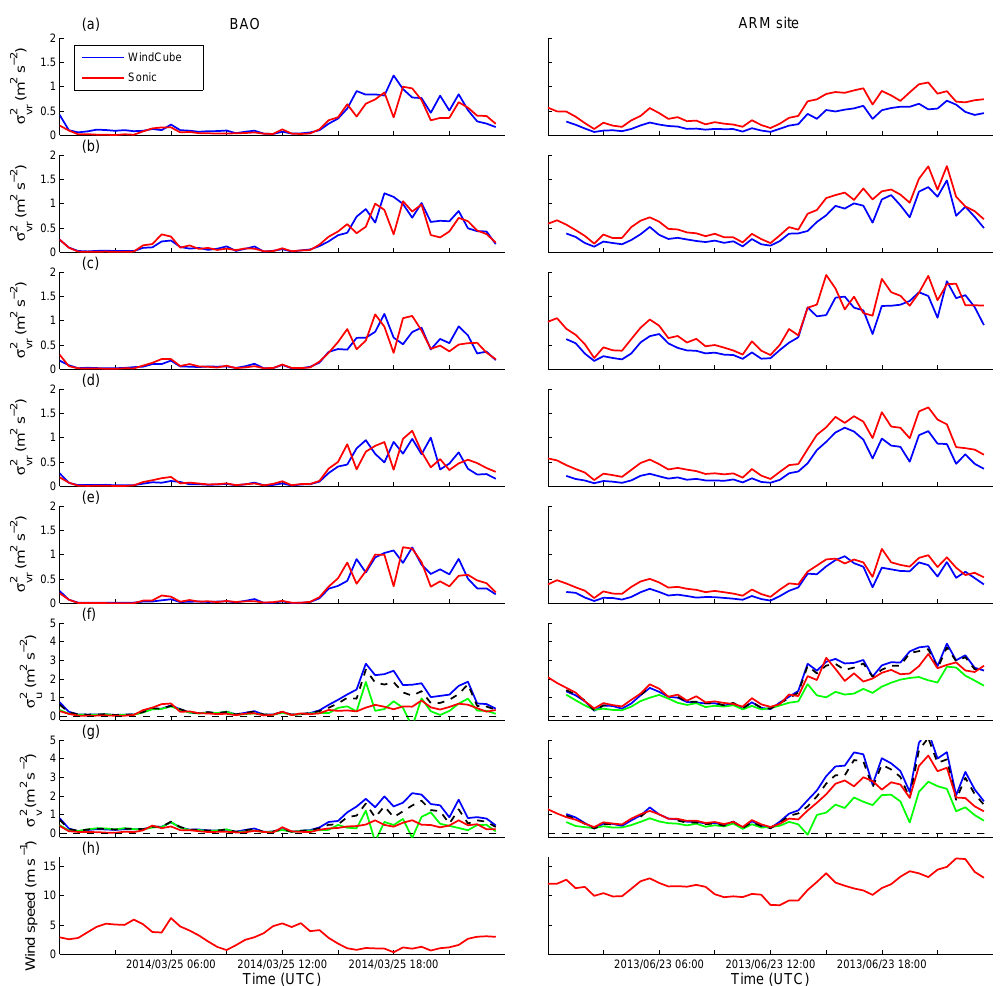
Figure 9. Thirty-minute (a) v r1 , (b) v r2 , (c) v r3 , (d) v r4 , and (e) v r5 variance values measured by WindCube lidar and calculated from projected sonic data, where positions 1–4 are located at azimuths of 0, 90, 180, and 270 ◦ , respectively, at an elevation angle of 62 ◦ and position 5 is pointed vertically. Values of (f) u variance and (g) v variance are also shown for reference, where sonic values are from standard variance calculation and WindCube values are shown from DBS calculation (solid blue line), five-beam calculation (green line), and corrected DBS calculation (dashed black line). Mean wind speed from sonic anemometer is shown in (h) . Data are shown from the BAO on 25 March 2014 at 100ma . g . l . (left panels) and from the ARM site on 23 June 2013 at 60ma . g . l . (right panels). The WindCube five-beam method results in large underestimates of u and v variance, especially under convective conditions at the BAO, while much better agreement is seen with the new variance correction